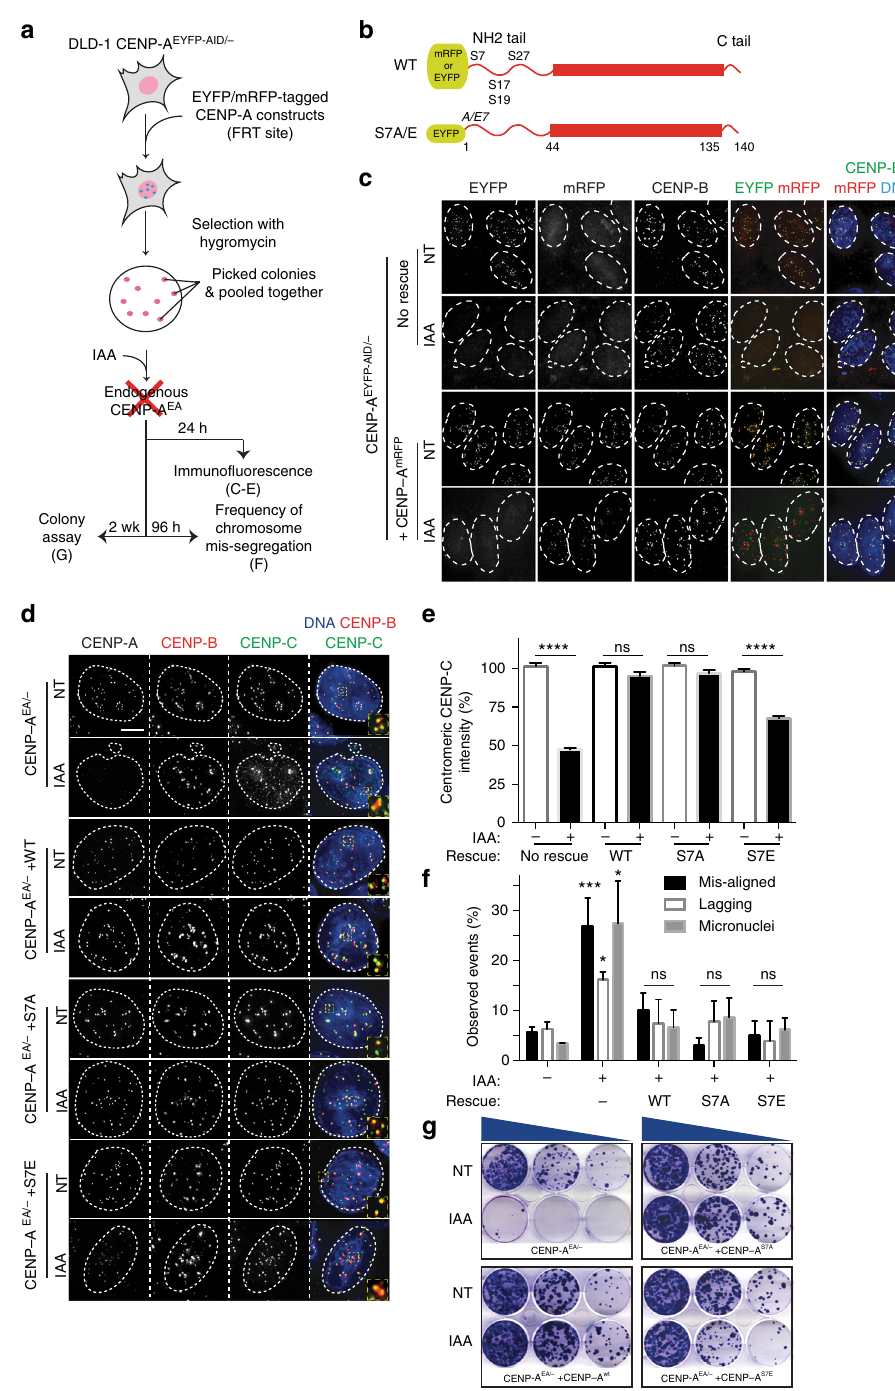
Fig. 1 CENP-A S7ph is not required for short-term centromere function. a Schematics of the experiments. b Schematics representing the different CENP-A constructs amino-terminally tagged with EYFP or mRFP. c Representative immuno fl uorescence images showing the working principles of the system. Following IAA treatment for 24 h the EYFP signal of endogenous CENP-A disappears in both cell lines, while the mRFP signal of the exogenous CENP-A remains at the centromere (marked by CENP-B spots) in the CENP-A mRFP cell line. Scale bar = 5 µ m. d Representative immuno fl uorescence images showing the localization of exogenous CENP-A constructs in the indicated cell lines. CENP-C staining is also shown revealing its localization in presence of exogenous CENP-A constructs (IAA treatment for 24 h). Scale bar = 5 µ m. e Quanti fi cation of CENP-C levels of the experiments in d . Error bars represent the SEM of three independent experiments. Unpaired t -test: **** p < 0.0001. f Quanti fi cation of mitotic errors in the indicated cell lines calculated by live- cell imaging observation after 2 days of IAA treatment. Error bars represent the SEM of four independent experiments. Unpaired t -test: *** p = 0.0008, * p = 0.012 and 0.017. g Representative images of crystal violet-stained colonies from the colony formation assay. Cells were grown for 14 days to test their clonogenic survival in presence or absence of endogenous CENP-A (controlled by IAA treatment). N = 3. Source data for graphs shown in e and f are provided as a Source Data fi